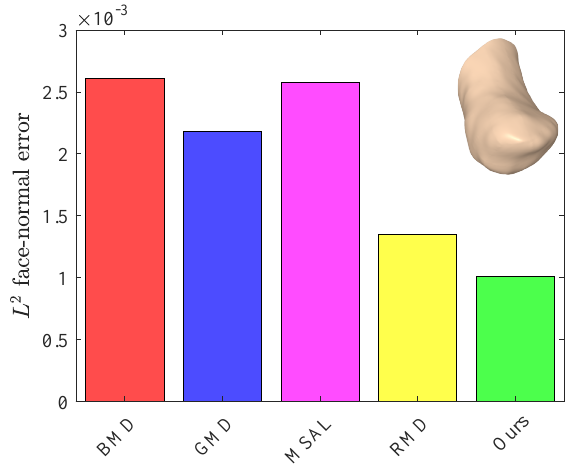
Figure 12. L 2 face-normal errors for the right metacarpal